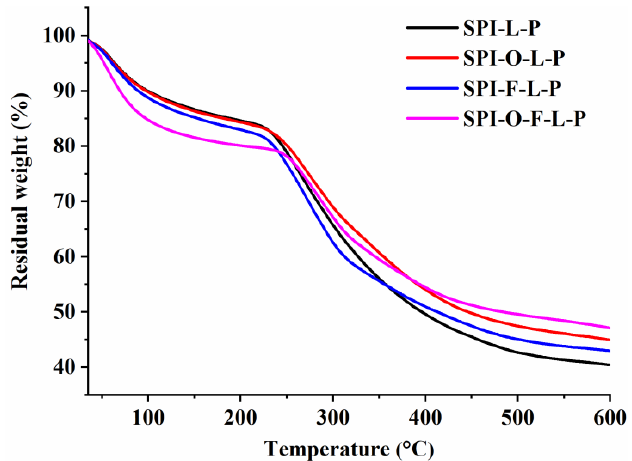
Figure 6. TGA curve of different samples.